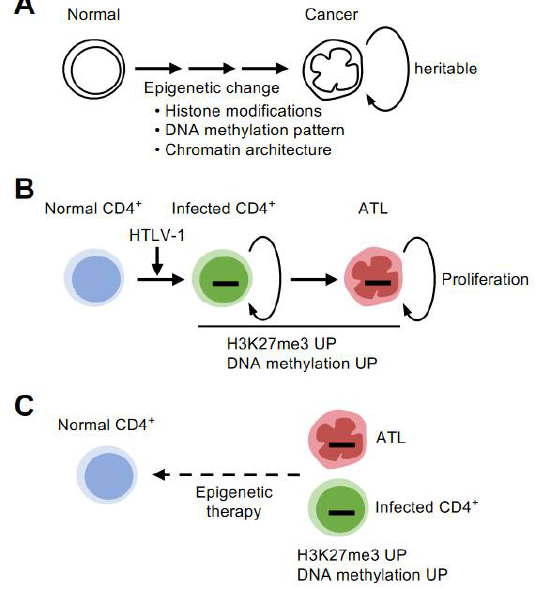
Figure 1. Early formation of epigenetic abnormalities. ( A ) Various abnormalities in epigenetic modifications accumulate during the transformation process from normal cells to tumor cells. The epigenetic changes, such as DNA methylation and histone modifications, can be inherited by the next generation of cells to form populations with the same characteristics. This has a high affinity with the endlessly proliferating nature of cancer. ( B ) T cells infected with HTLV-1 gradually develop into high-grade ATL cells with abnormal accumulation of H3K27me3 and DNA methylation. Such epigenomic abnormalities are common characteristics of infected and highly proliferating ATL cells. ( C ) Epigenetic changes are highly plastic. It is essential to clarify the direction and mechanism of epigenetic abnormalities in infected and tumor cells. Then, by precisely targeting them as therapeutic candidates, the concept of restoring the undesired epigenomic characteristics to their original state can be established.